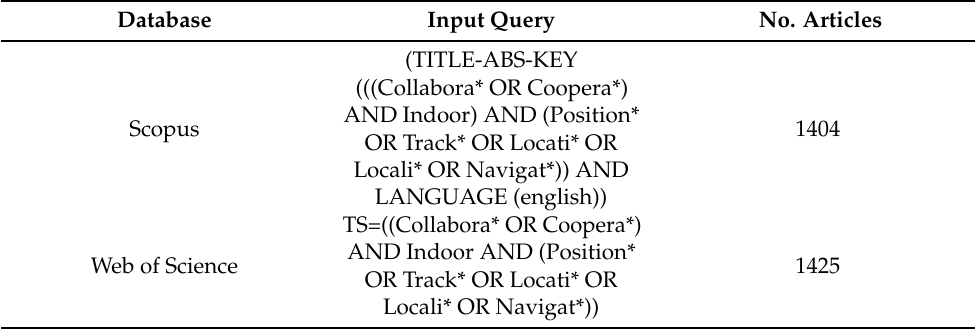
Table A1. Scopus and Web of Science search